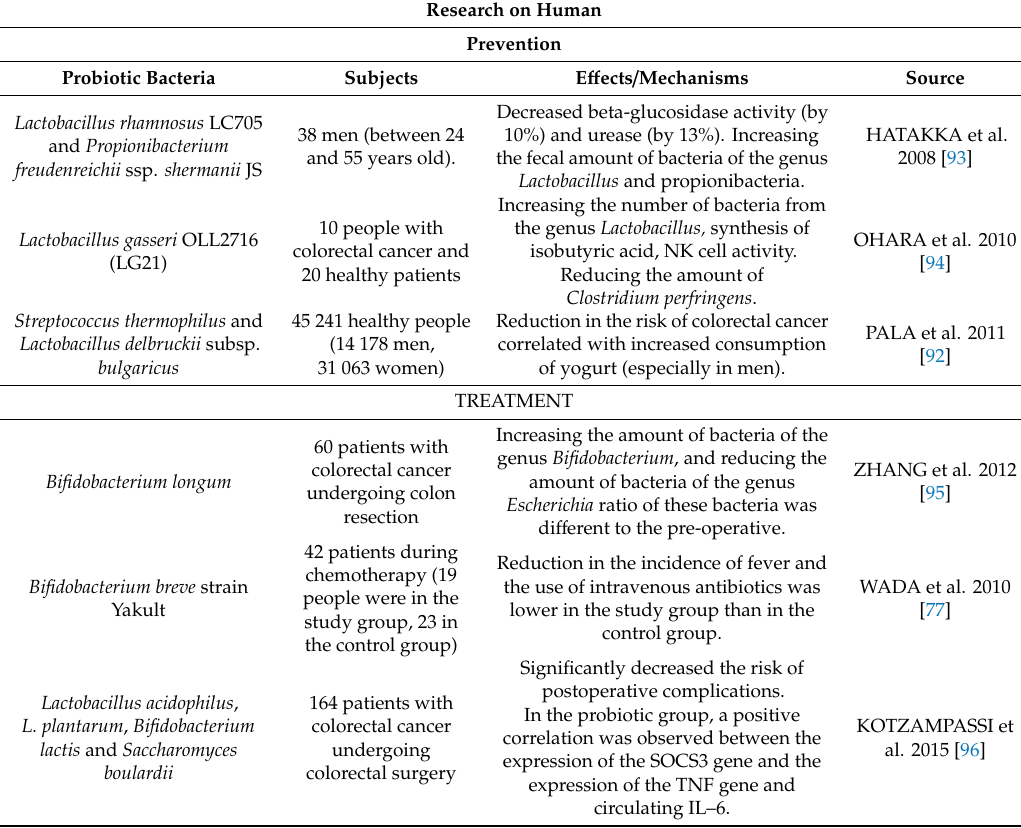
Table 3. The results of the impact of probiotic bacteria in the prevention and in the treatment of colon